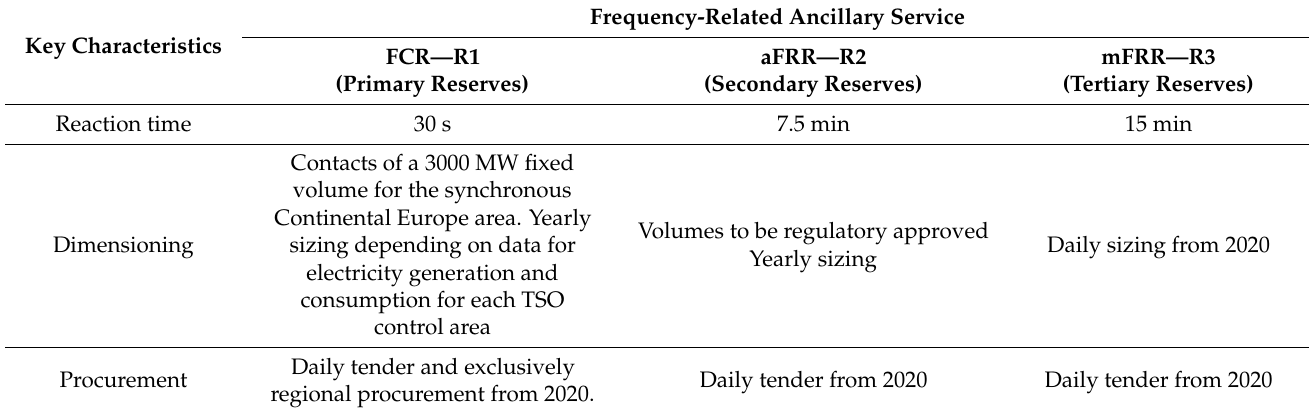
Table 2. Key characteristics of Belgium ancillary